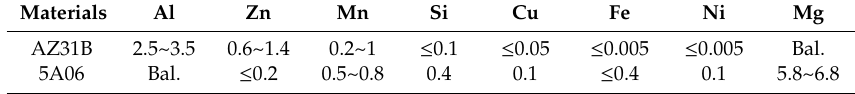
Table 1. The nominal composition of AZ31B magnesium (Mg) and 5A06 aluminum (Al) (in wt.%). Materials